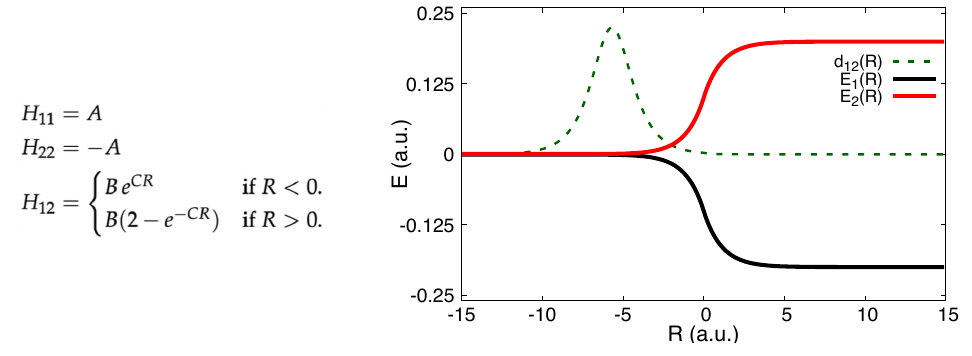
Figure 2. Analytical form of the electronic Hamiltonian on the left , with the BO potential energy surfaces (red and black) and NAC (dashed green) shown on the right for ECR